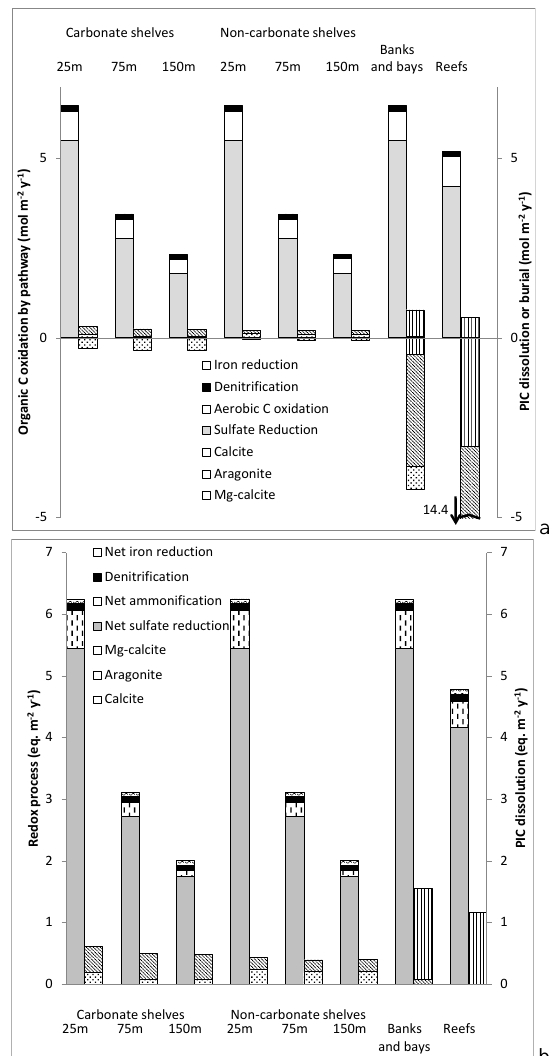
Fig. 2. Processes generating DIC (a) and alkalinity (b) for the banks and bays, reef, carbonate shelf, and non-carbonate shelf environ- ments. Baseline POC flux. Processes contributing < 1% to the total are not